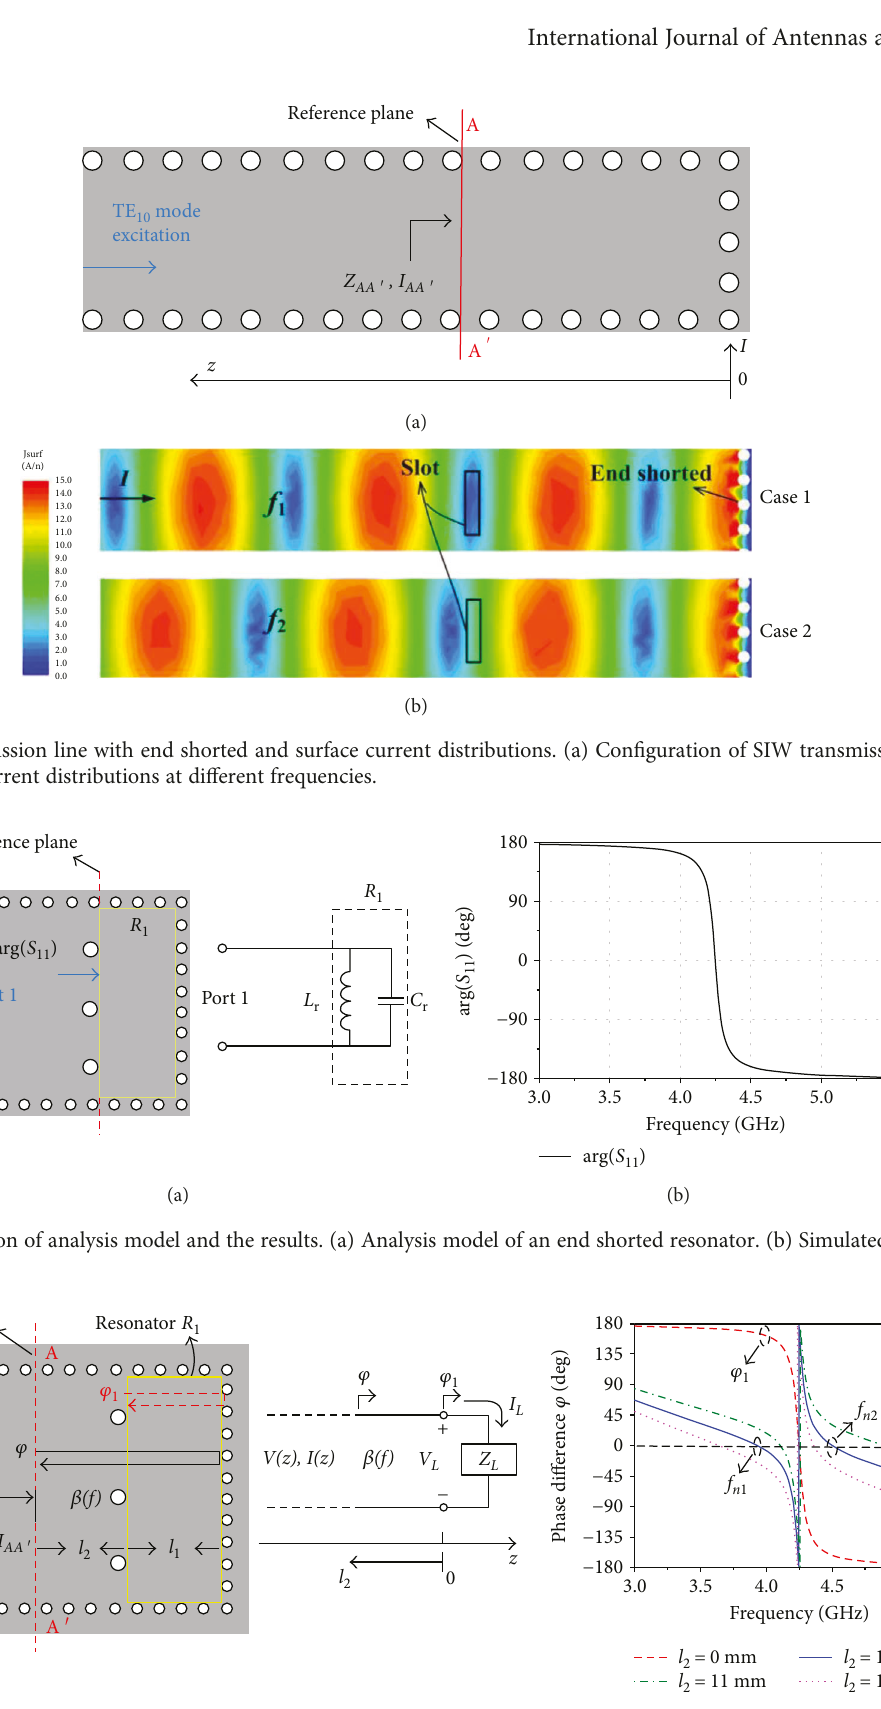
Figure 6: Illustration of analysis model and the results. (a) Analysis model of Ant. 2. (b) Simulated phase di ff